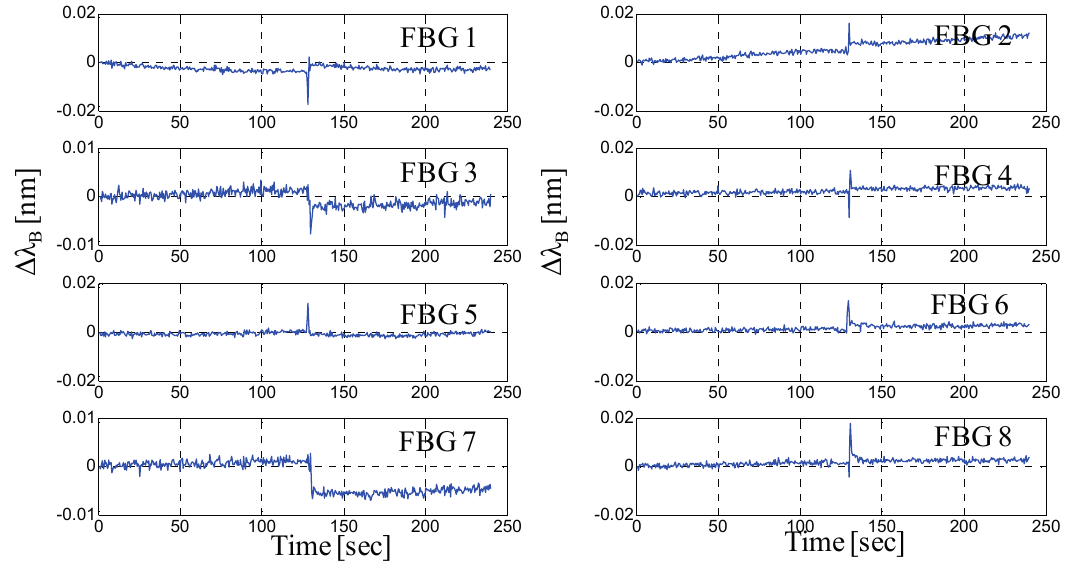
Figure 10. Bragg wavelength shift versus time for the eight FBGs.